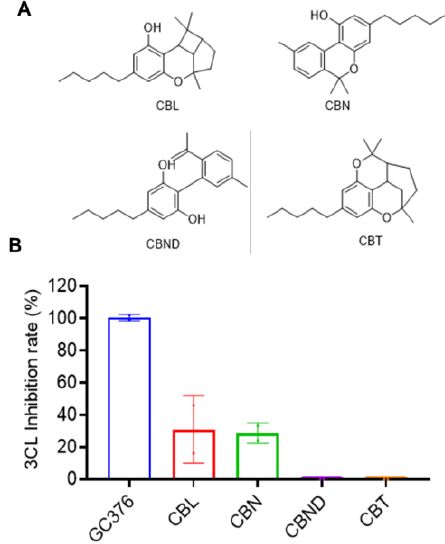
Figure 5. The chemical structures of other types of cannabinoids ( A ) and their inhibitory effect on the activity of SARS-CoV-2 M pro ( B ). These cannabinoids were tested at a concentration of 10 µ M with the MBP-tagged SARS-CoV-2 M pro inhibition assay. GC376 was used as the positive control and each test compound was assayed in triplicate.